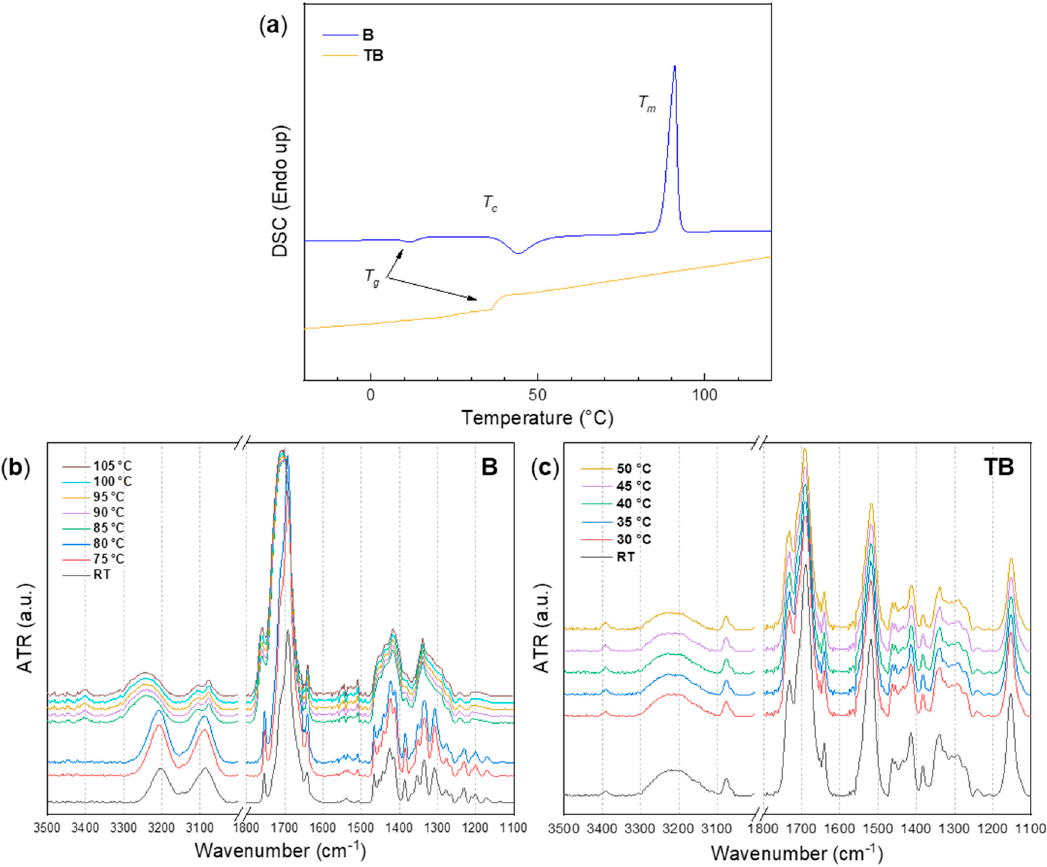
Figure 3. ( a ) DSC curves (heating rate of 5 K/min, the thermal history was cancelled by the preheating and cooling circle); ( b ) and ( c ) the ATR FT-IR spectra at various temperatures of model compounds B and TB . T g : glass transition temperature; T c : crystallization temperature; T m : melting temperature.